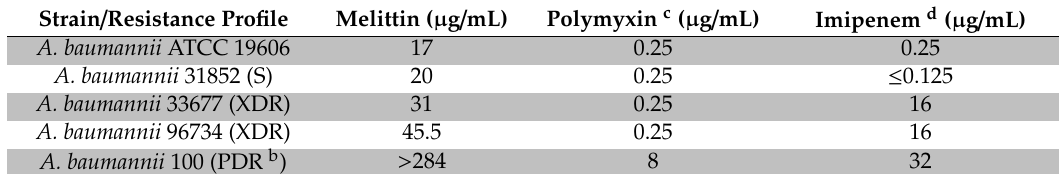
Table 1. Measured minimum inhibitory concentration (MIC) values for melittin, polymyxin and imipenem.